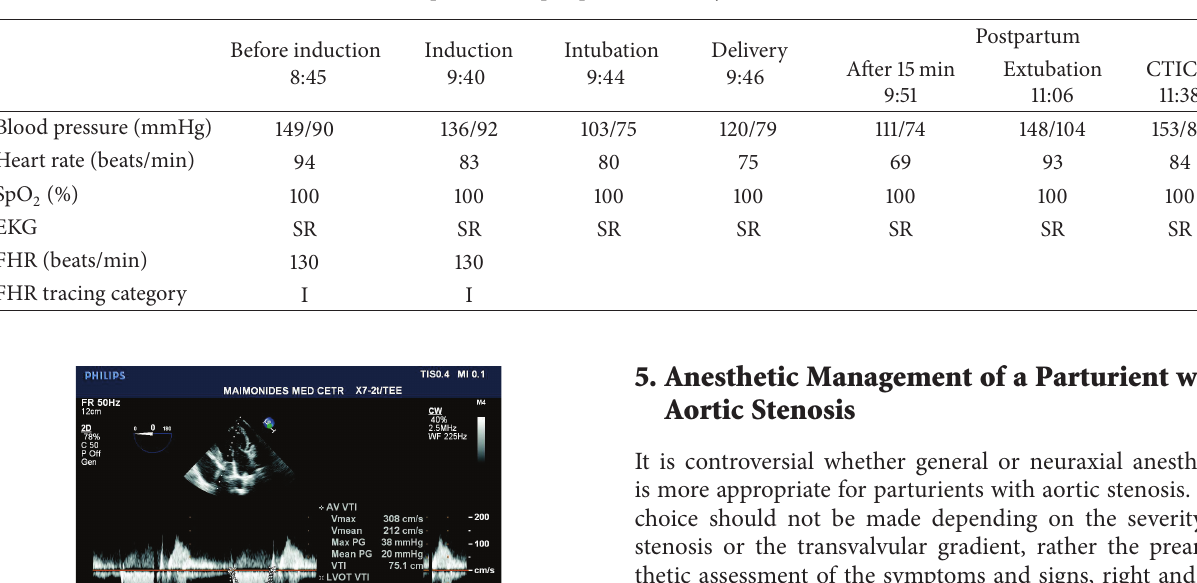
Table 2: Intrapartum and postpartum hemodynamic measurements.